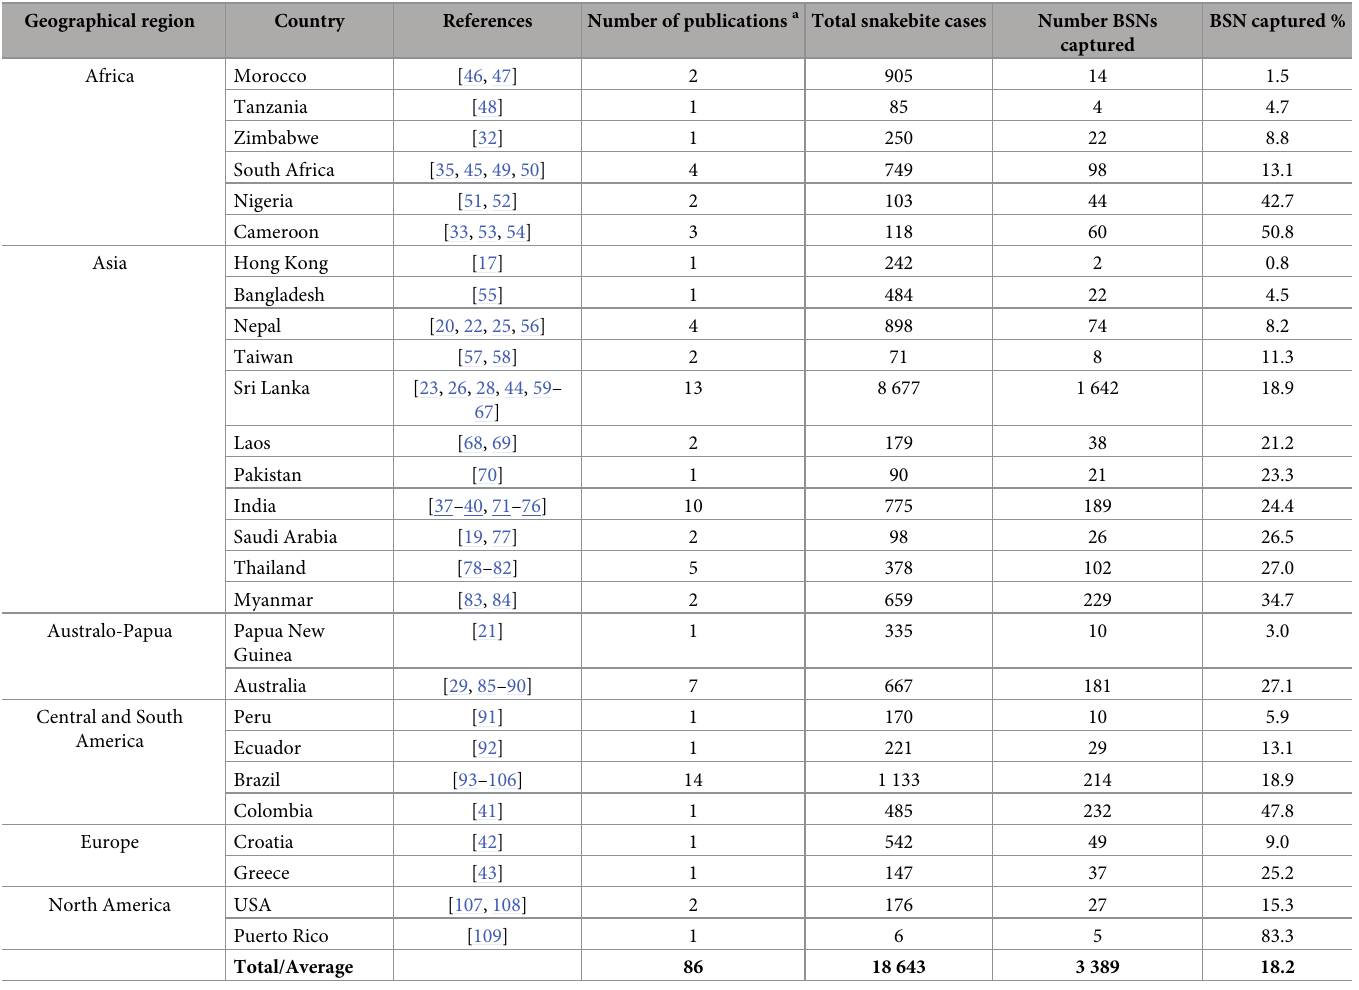
Table 3. Geography and number of snakebite cases where the BSN was captured/killed by victims/bystanders. Geographical